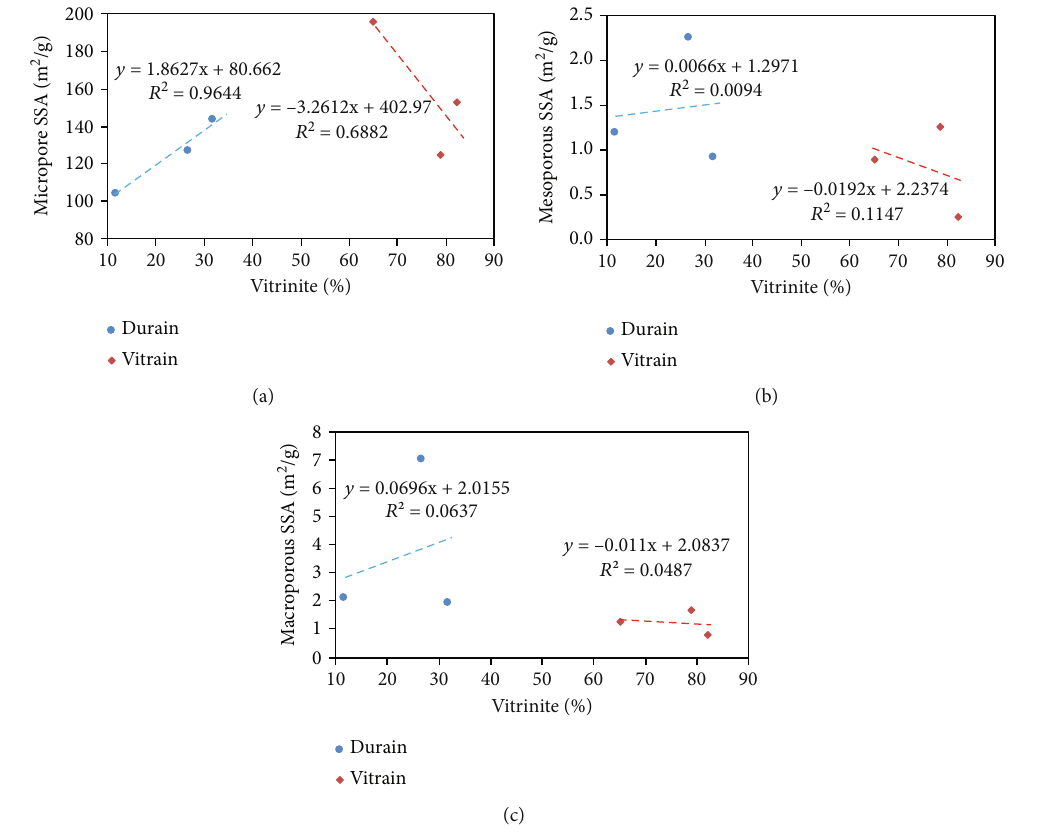
Figure 13: Correlation between vitrinite content and SSA. (a) Micropore; (b) mesopore; (c)